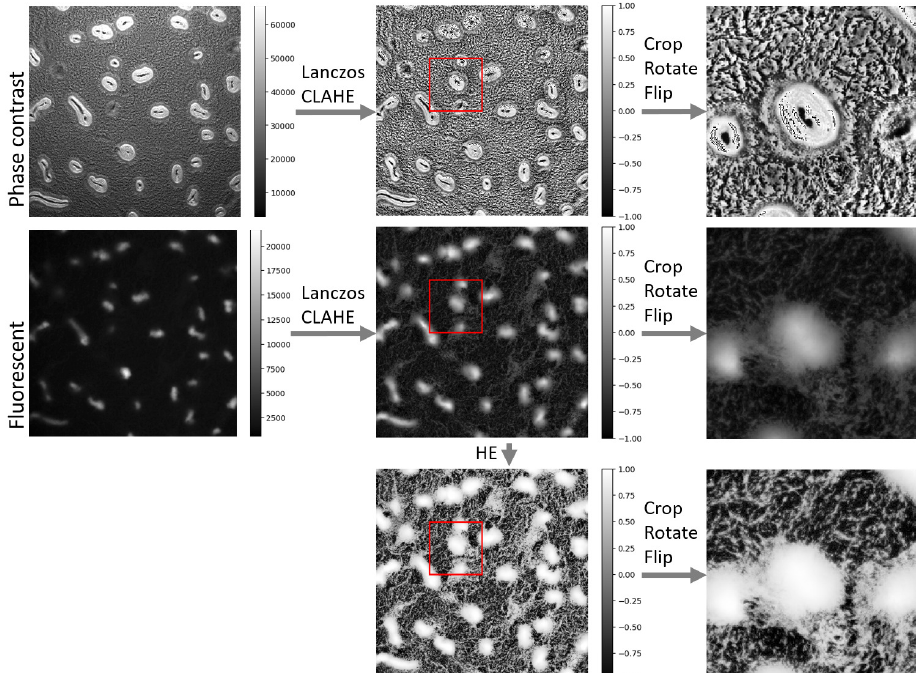
Figure 1. Image-processing pipeline. The intensity ranges are shown in the color bars, and the cropped regions are shown in red boxes. Phase contrast and fluorescent images are from the same experimental replicate and time point. LANCZOS—The Lanczos algorithm; CLAHE—Contrast Limited Adaptive Histogram